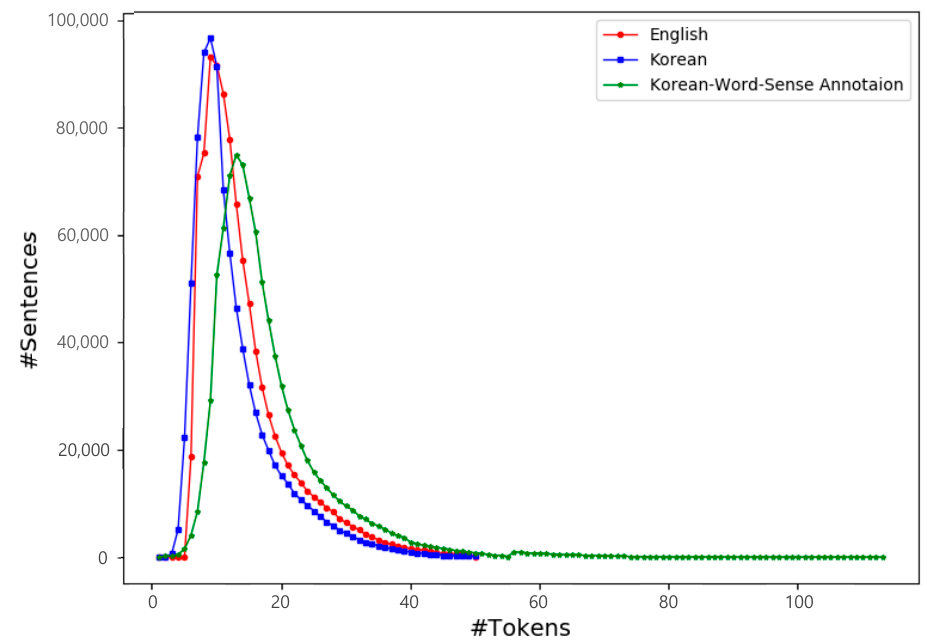
Figure 5. Sentence length distributions of the Korean-English parallel corpus.